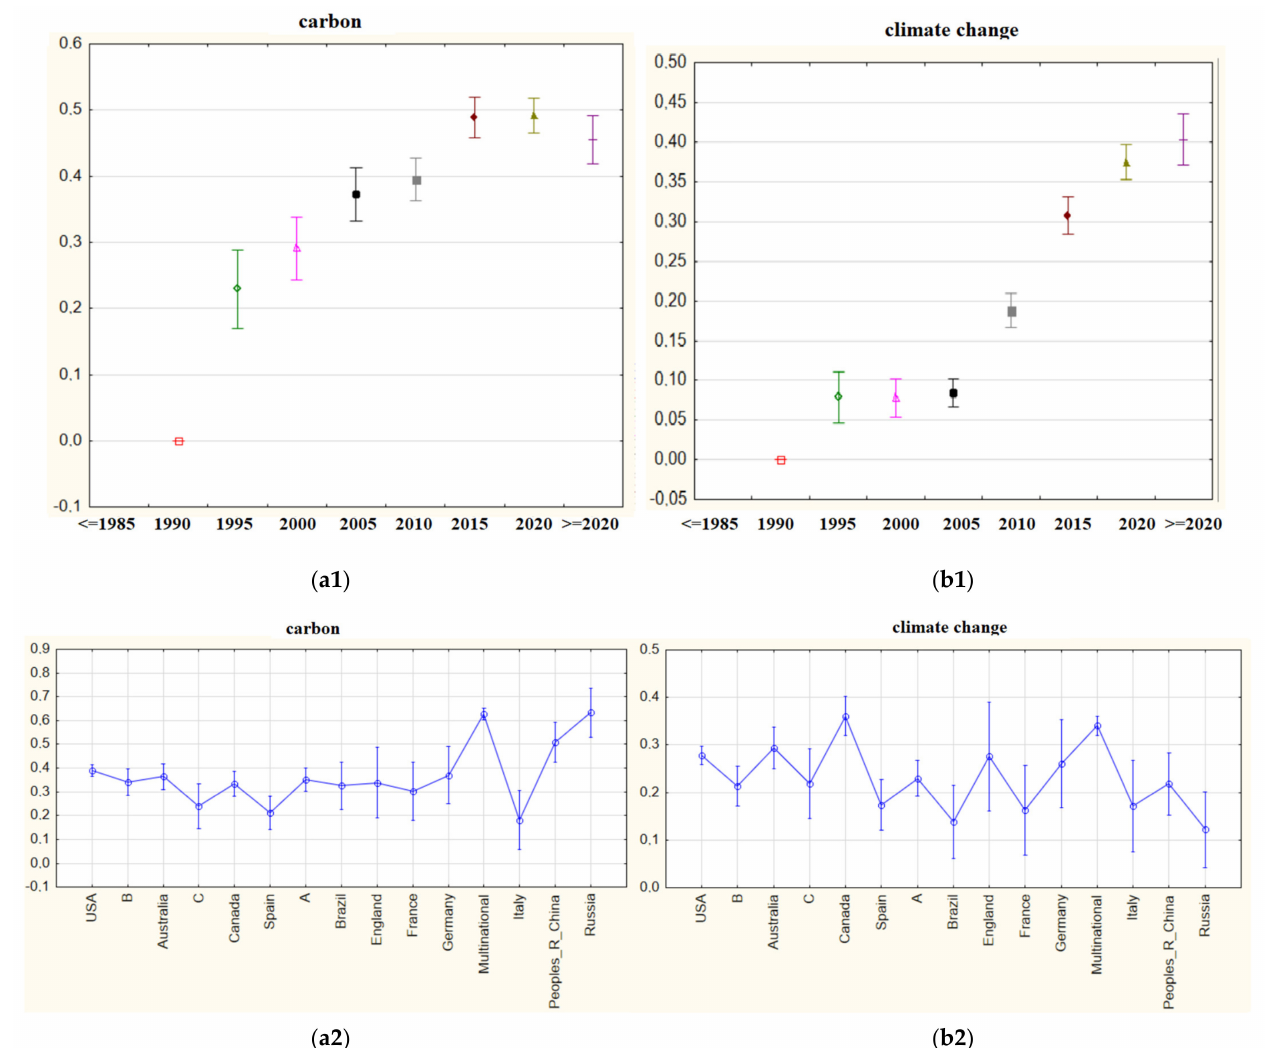
Figure 10. ( a1 ) mean importance weights of the indexed word “carbon” for five-year periods; ( b1 ) mean importance weights of the indexed term “climate change” for five-year periods; ( a2 ) mean importance weights of the indexed word “carbon” via countries; ( b2 ) mean importance weights of the indexed term “climate change” via